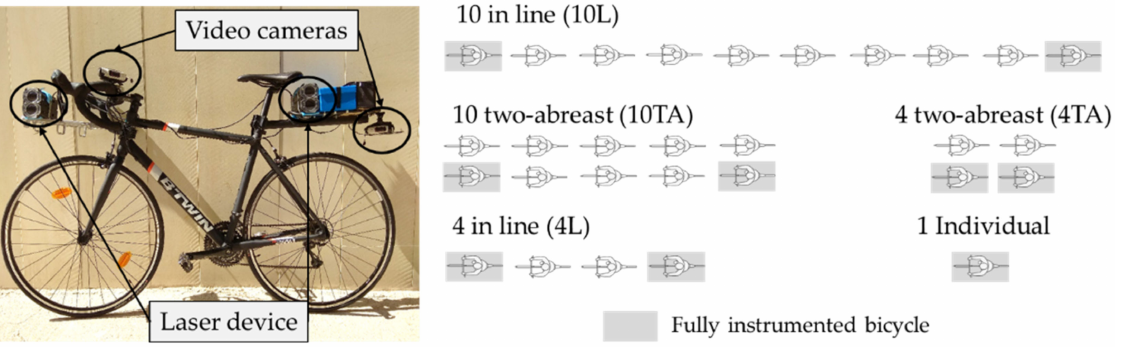
Figure 2. Instrumented bicycle and cyclists’ group